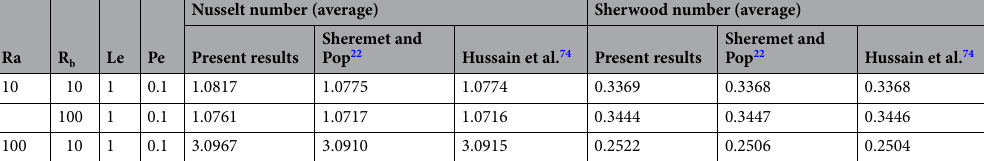
Table 4. Comparative assessment of the thermo-bioconvection in-between the present result with published results 22,74 using average values of Nu and Sh when Ra = 10, Pr = 1, Le = 1.